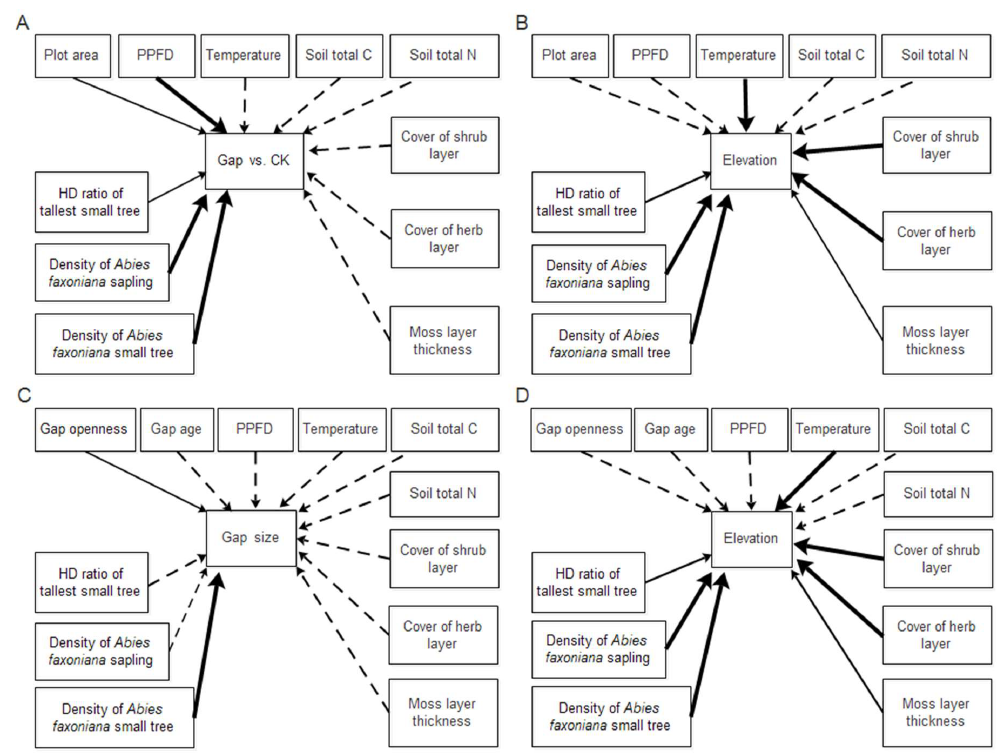
Figure 4. MANOVA analyses results showing endogenous variables difference estimates. Solid lines indicate the endogenous variables were significantly affected by the exogenous variables, and dash lines indicate the non-significant relationship between the endogenous variables and exogenous variables ( p ≥ 0.05). Solid line width is weighted by the magnitude of significant coefficients (thick lines represent p < 0.001, and fine lines represent p < 0.05). ( A , B ) Data include forest gap ( N = 26) and CK ( N = 8). ( C , D ) Data only show the difference in forest gaps ( N = 26).